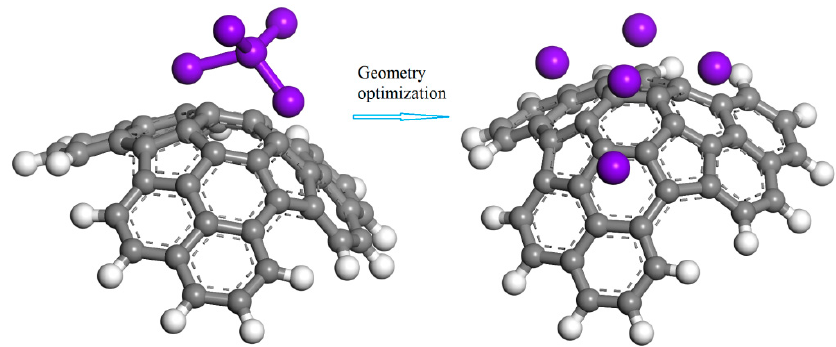
Figure 3. The relaxation process from the initial atomic cluster to dispersed adsorption at adjacent sites for multiple Sc atoms being doped around the ZTC surface center, with the gray, white and violet balls representing carbon, hydrogen and scandium atoms respectively.